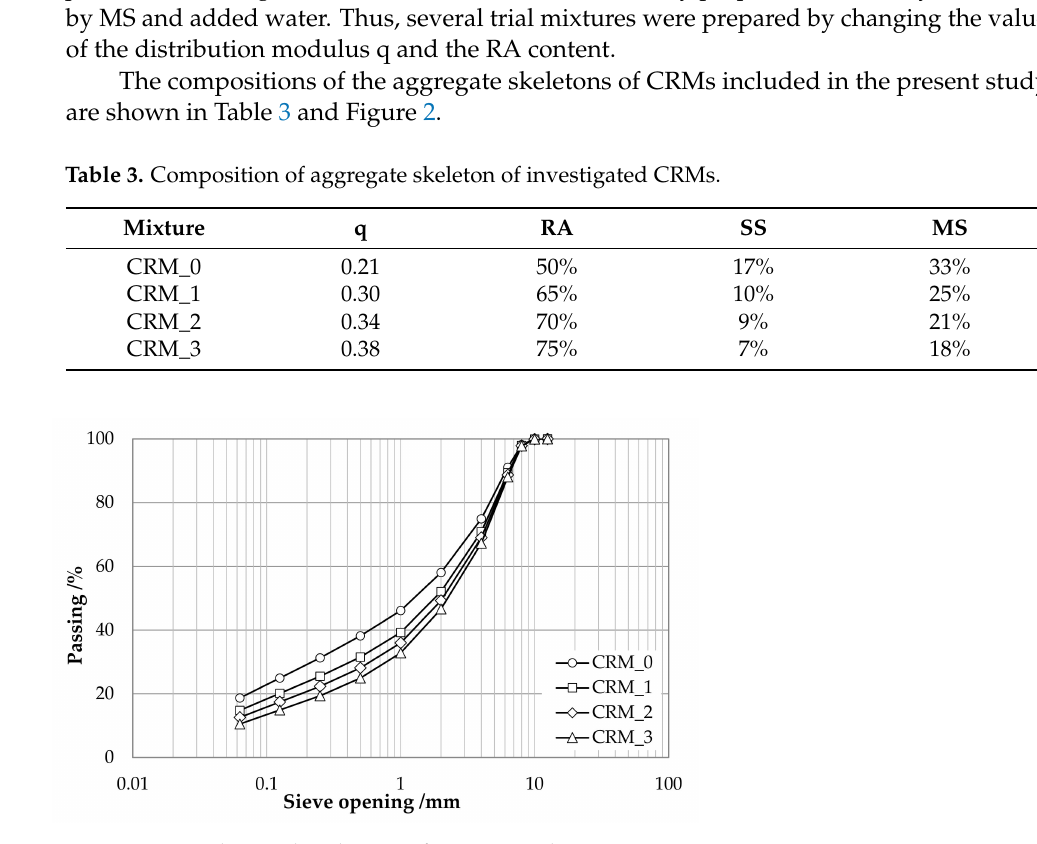
Figure 2. Particle size distribution of investigated